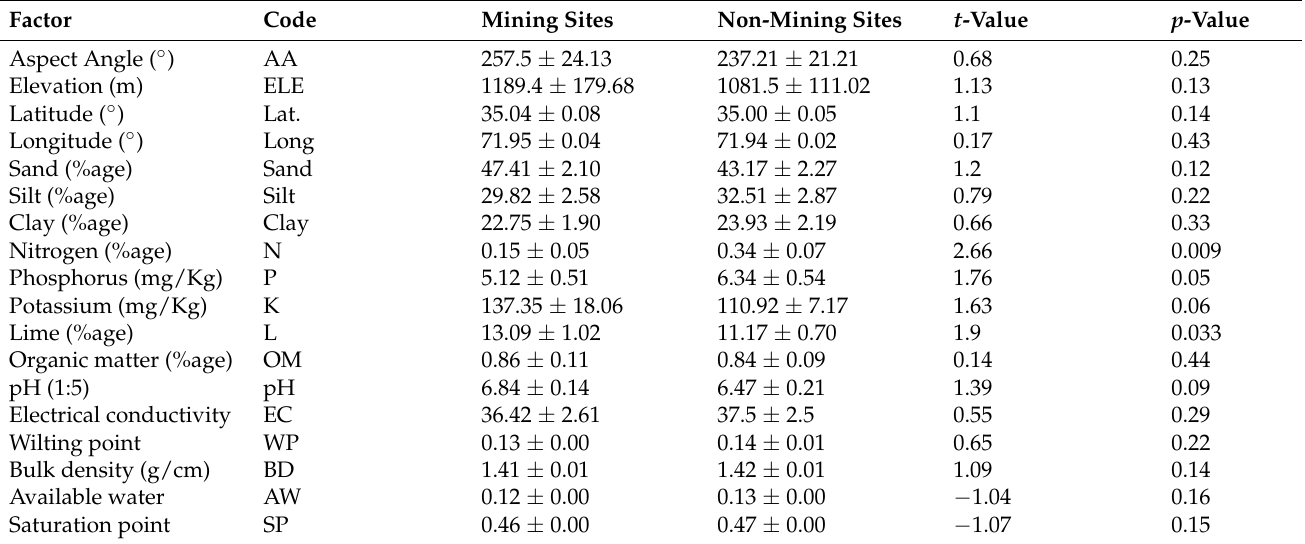
Table 2. Descriptive value (Mean ± SD) of environmental variables affecting the vegetation sites of mining and non-mining